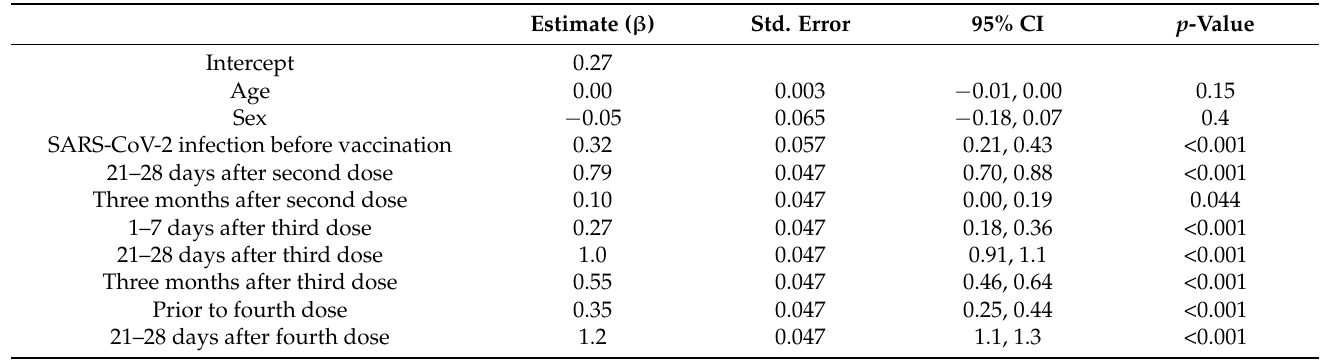
Table 2. Mixed model of the anti-S1 and -S2 antibody titers against SARS-CoV-2.